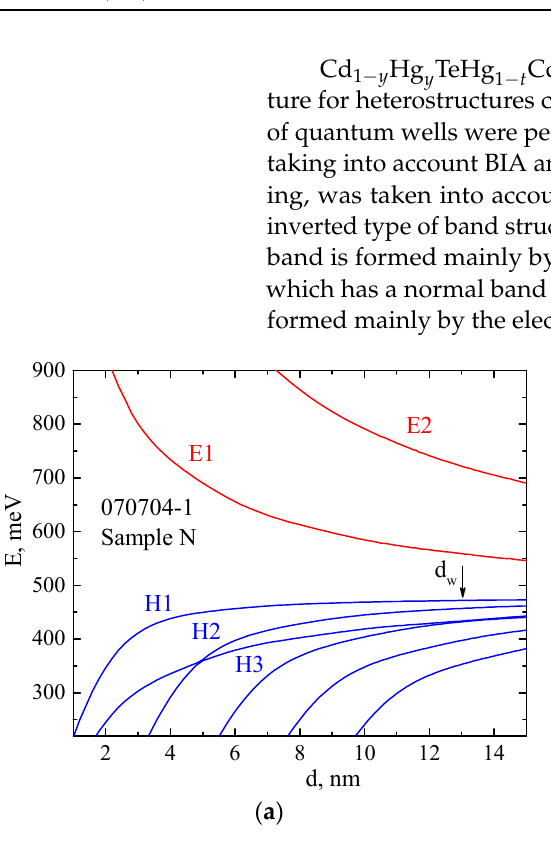
Figure 1. Energies of size-quantized subbands at k = 0 as a function of the Hg (cid:2869)(cid:2879)(cid:3047) Cd (cid:3047) Te quantum well width for t = 0.15 (Sample N) ( a ) and t = 0.05 (Sample I) ( b ).